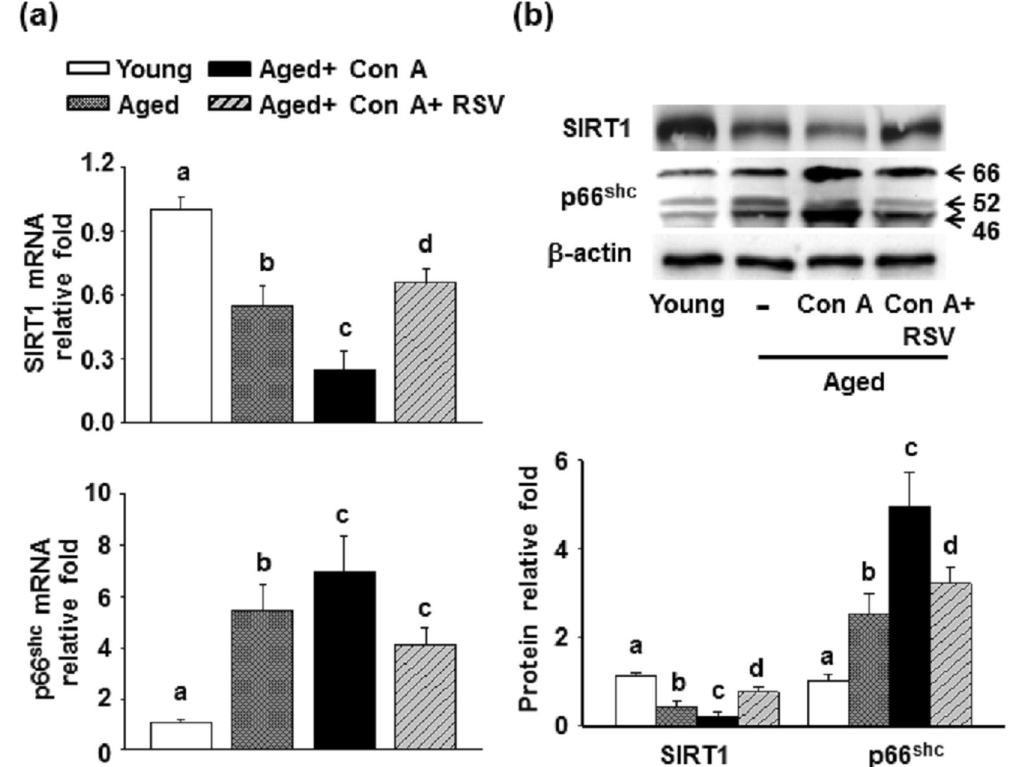
Figure 3. Effects of resveratrol on hepatic levels of SIRT1 and p66shc in aged mice treated with Con A. ( a ) mRNA and ( b ) protein levels of SIRT1 and p66shc in the liver tissues of mice were detected by RT-qPCR and Western blotting, respectively. The data are expressed as the means ± SEMs from three independent measurements. Different letters indicate statistically significant differences (p < 0.05) between the